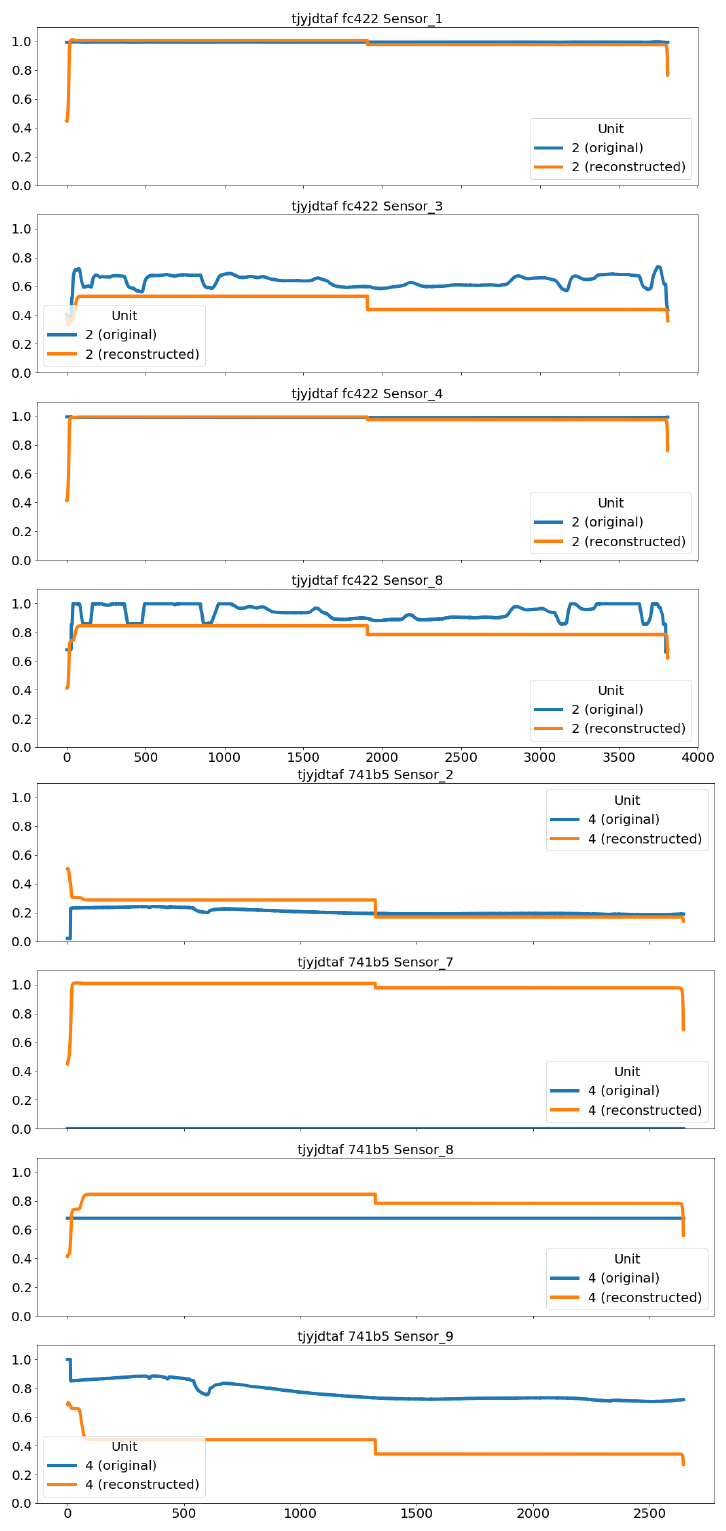
Figure 13. LSTMAE signal reconstruction examples (run lstmae_pca_10 ) of the same two flights and sensors from Figure